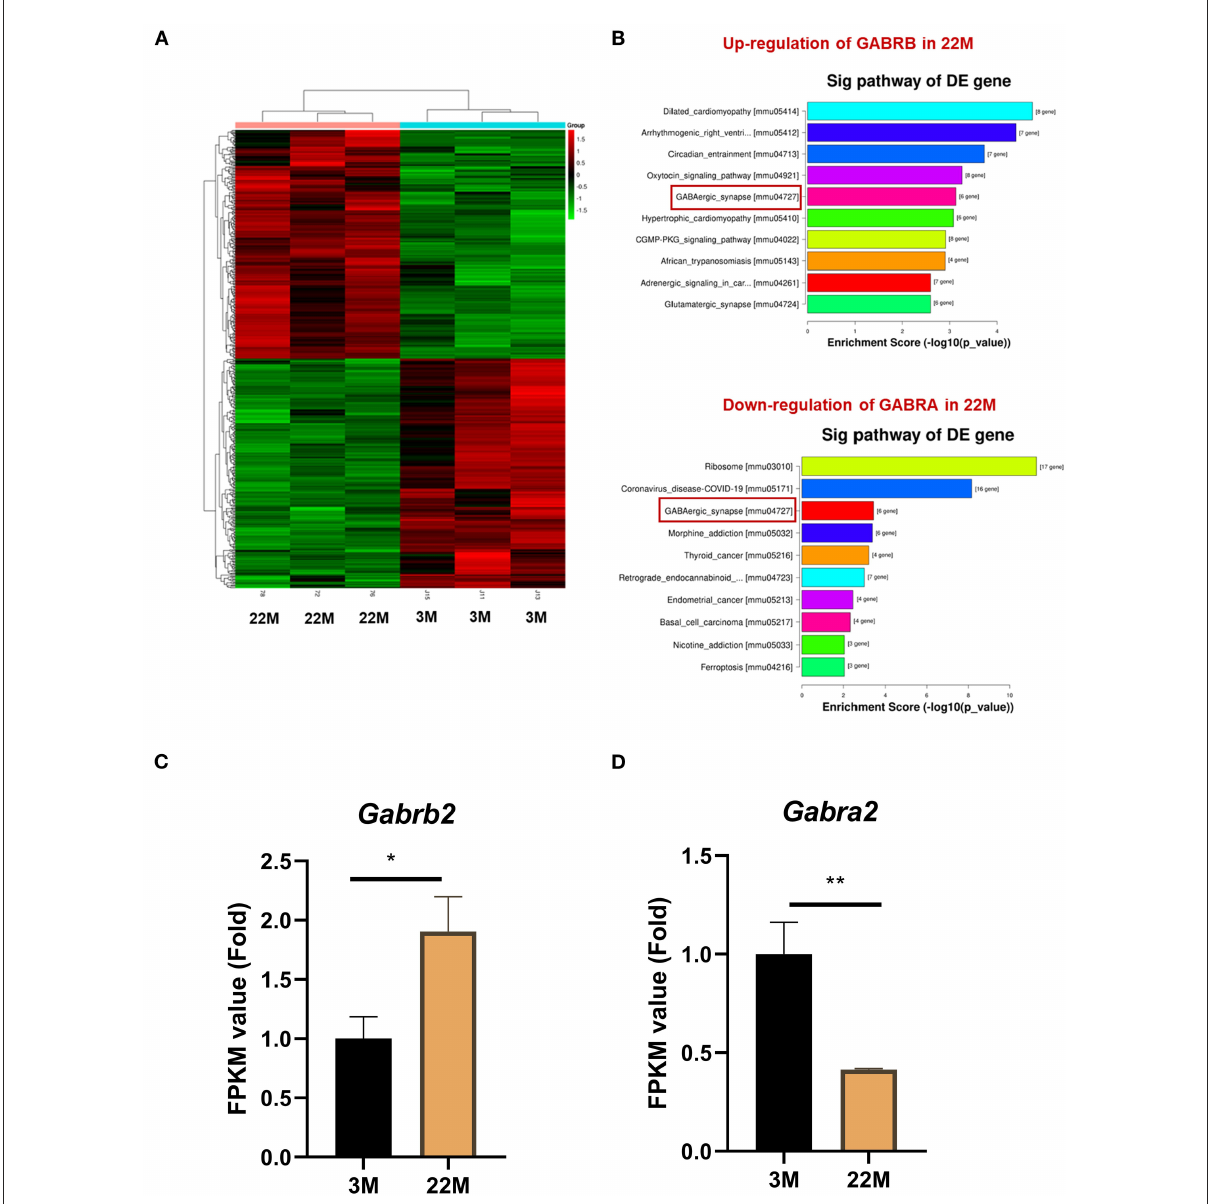
FIGURE3 GABRB2 and GABRA2 expression were evaluated by mRNA-seq of hippocampus in aging mice. (A) Heat map of hippocampus between 3M and 22M group. (B) KEGG analysis of the hippocampus between 3M and 22M group. (C,D) FPKM value of GABRB2 and GABRA2 in the hippocampus by mRNA-seq. Data were represented as mean ± SD and were analyzed by Student t -test. * P < 0.05 and ** P < 0.01.